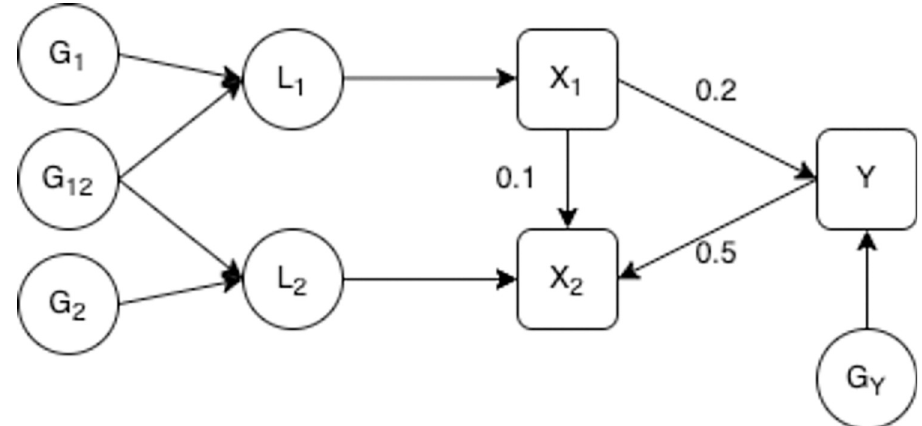
Fig 3. Model with a causal effect from the outcome to the later time point. – L 1 is the liability in the first time period, L 2 is the liability in the second period. G 1 is a set of genetic variants associated with L 1 , G 2 is a set of genetic variants associated with L 2 and G 12 is a set of genetic variants associated with both L 1 and L 2 . G variants associated with the outcome. X 1 and X 2 are observed values of the exposure, where X 2 is observed at a later point in an individual’s life than X 1 . Y is an outcome. X 1 , X 2 and Y are confounded by a set of unobserved confounders U . X 1 and X 2 are measured with error, this measurement error is uncorrelated with the genetic variants. The direct causal effect of X 1 on X 2 and Y , and Y on X 2 are given on the